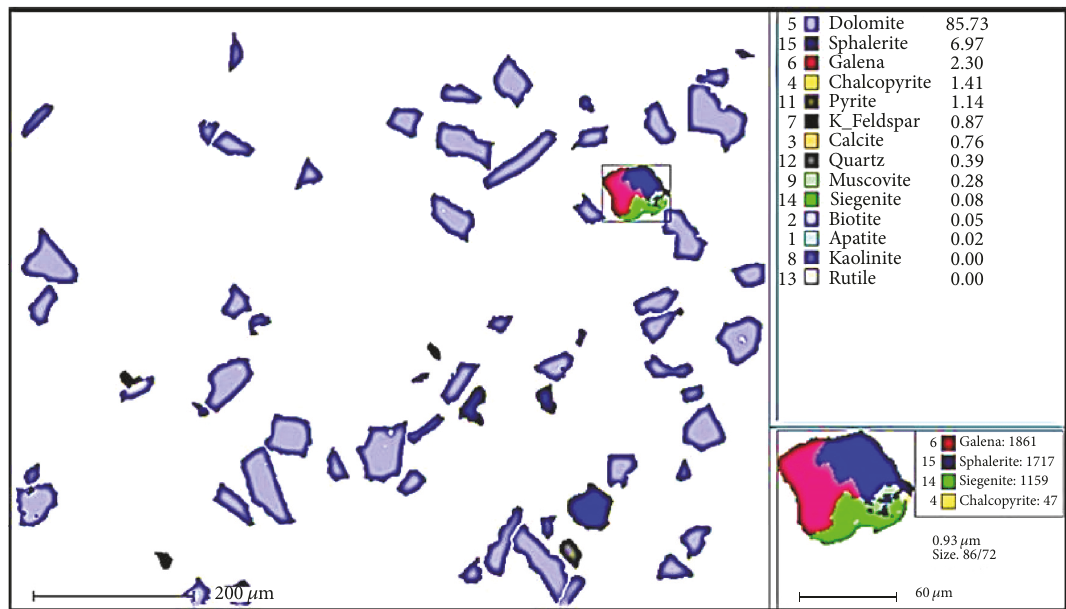
Figure 4: Classified MLA image of mineral associations found in the flotation feed. The inset shows minerals association within a grain of an approximate size of 60 microns (red: galena, blue: kaolinite, green: siegenite (cobalt-nickle sulfide), yellow: chalcopyrite, and navy: sphalerite).